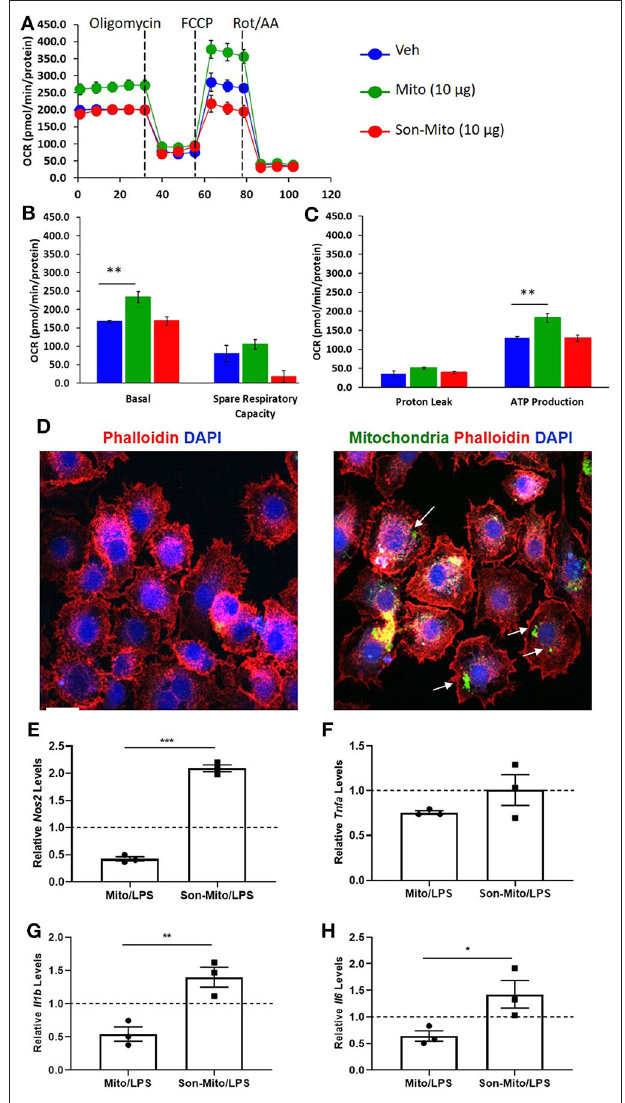
FIGURE 8 | Mitochondria donation from DCs induce anti-inflammatory phenotype in macrophages. (A) Seahorse analysis of RAW264.7 cells treated with healthy mitochondria (Mito) or structurally unhealthy (Son-Mito) for 24h. (B,C) Oxygen consumption rate of RAW264.7 cells measure basal, spare respiratory capacity, proton leak and ATP production. The assay was normalized to total protein. (D) RAW264.7 cells were treated with 0 or